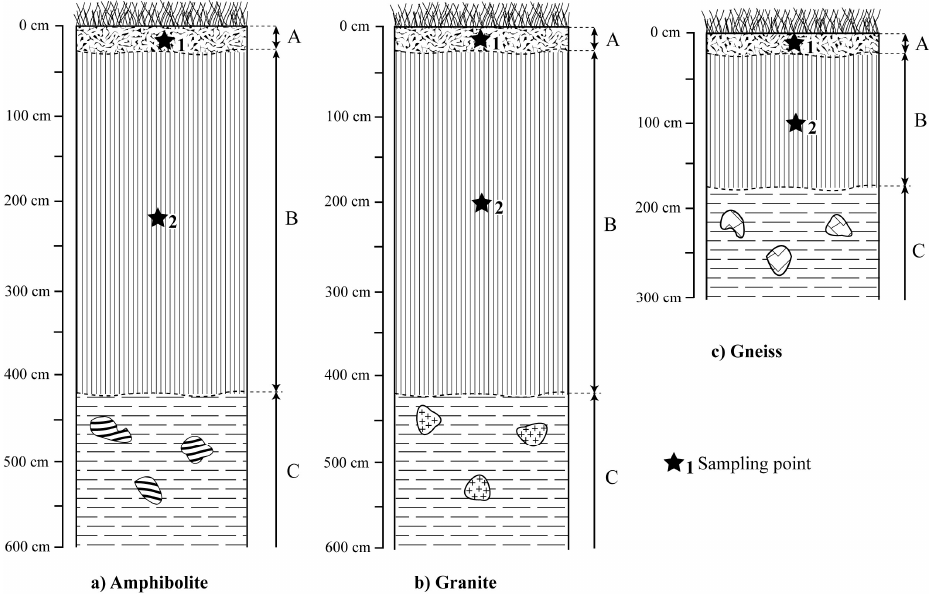
Figure 2. Macroscopic organization of the studied soil profile. ( a ) Soil profile developed on amplhibolite; ( b ) Soil profile developed on granite; ( c ) Soil profile developed on gneiss.